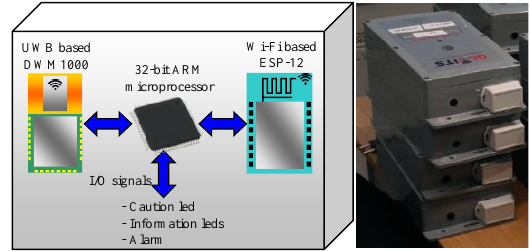
Figure 5. Anchor topology structure and photograph in used RTLS.